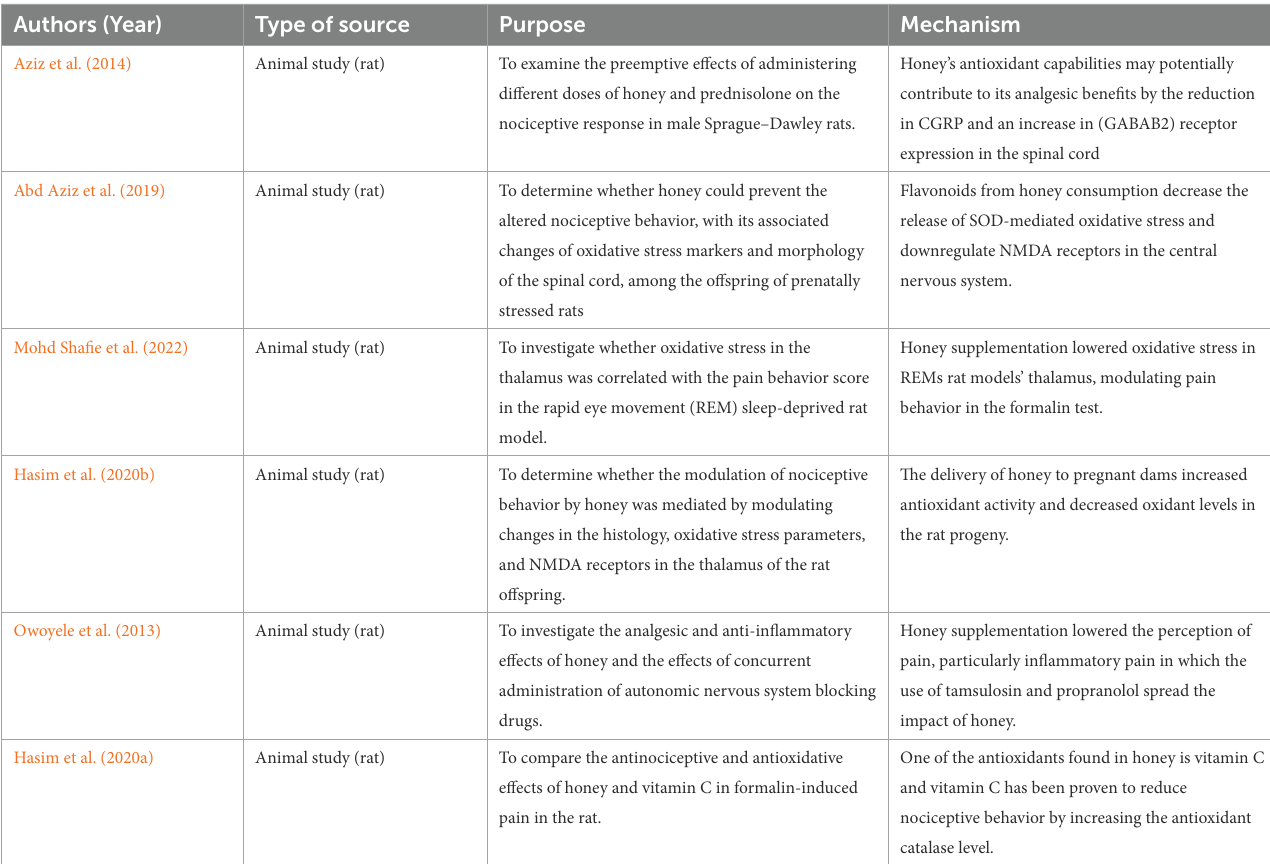
TABLE 5 Anti-nociceptive potentials of honey supplementation on animal models. Authors